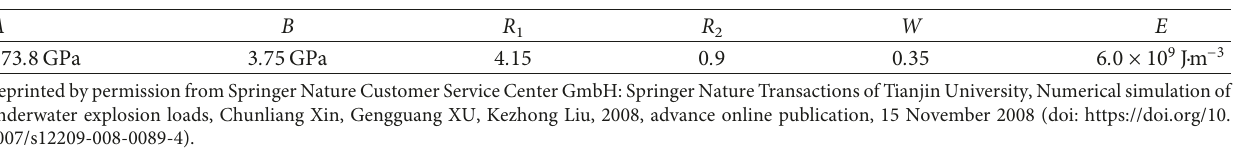
Figure 3: The numerical model and pressure distributions of free-field underwater explosion. (a) Numerical model. (b) t � 0 . 15 ms. (c) t � 0 . 72ms. Table 1: The parameters of the JWL equation [25, 44].